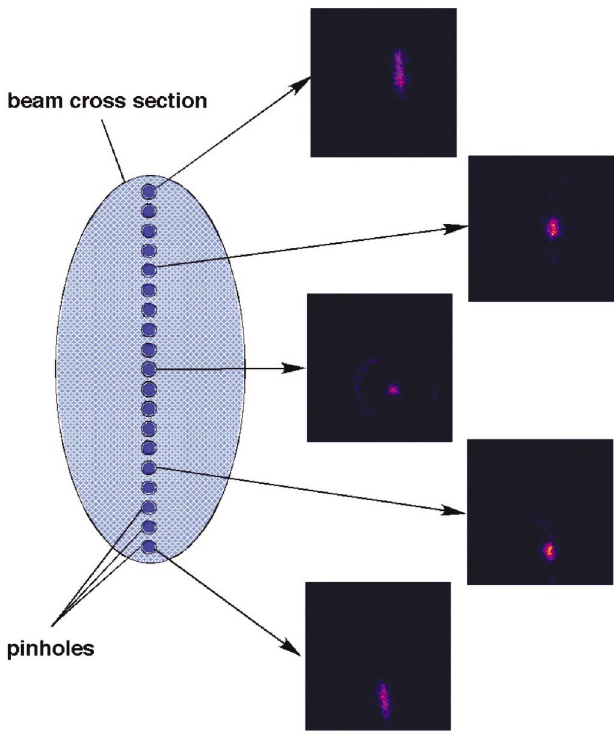
FIG. 5. (Color) Beam imaging technique to measure the phase- space distribution f (cid:9) x; y; x 0 ; y 0 (cid:10)